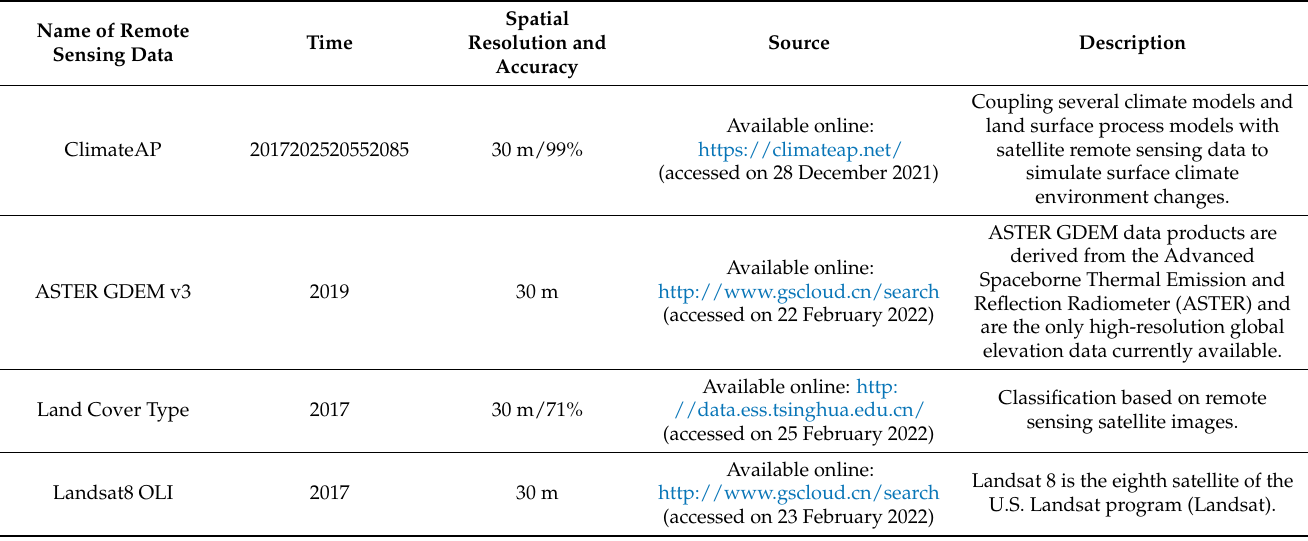
Table A1. Summary of remote sensing data and products used in this